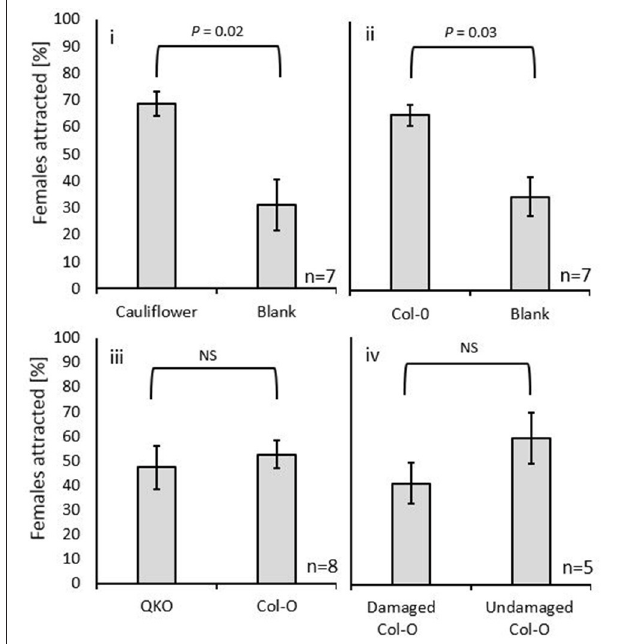
FIGURE 4 | The attraction of the C. nasturtii in Y-tube bioassays to (i) cauliflower vs. blank; (ii) Arabidopsis thaliana Co1-0 (no green leaf volatiles) vs. blank; (iii) A. thaliana Co1-0 vs. A. thaliana glucosinolate knockout plants (QKO); and (iv) undamaged vs. mechanically damaged A. thaliana Co1-0. Female attraction to the two odors was compared by Wilcoxon signed-rank. P -values are displayed over each comparison.